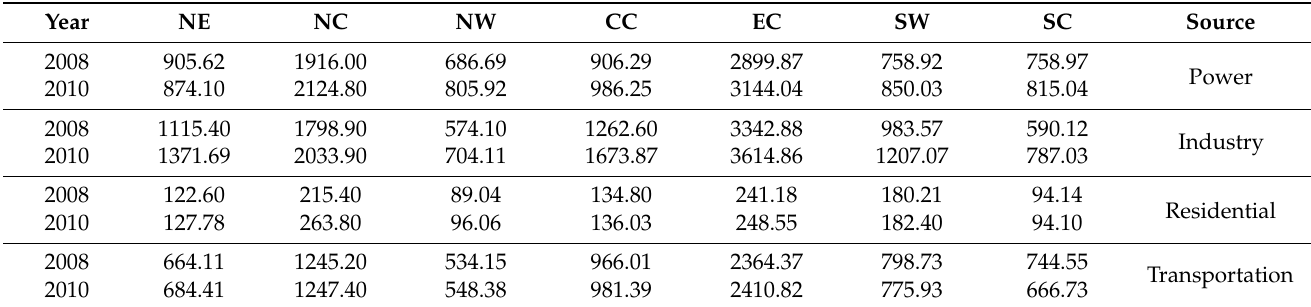
Table 1. NO x emissions from different sources over China in 2008 and 2010 (t · km − 2 · month − 1 ).